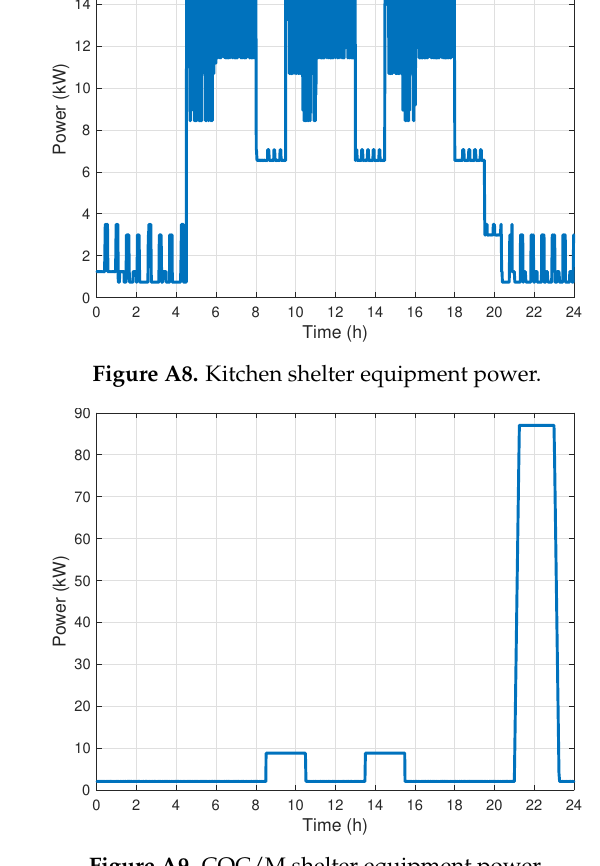
Figure A9. COC/M shelter equipment power.